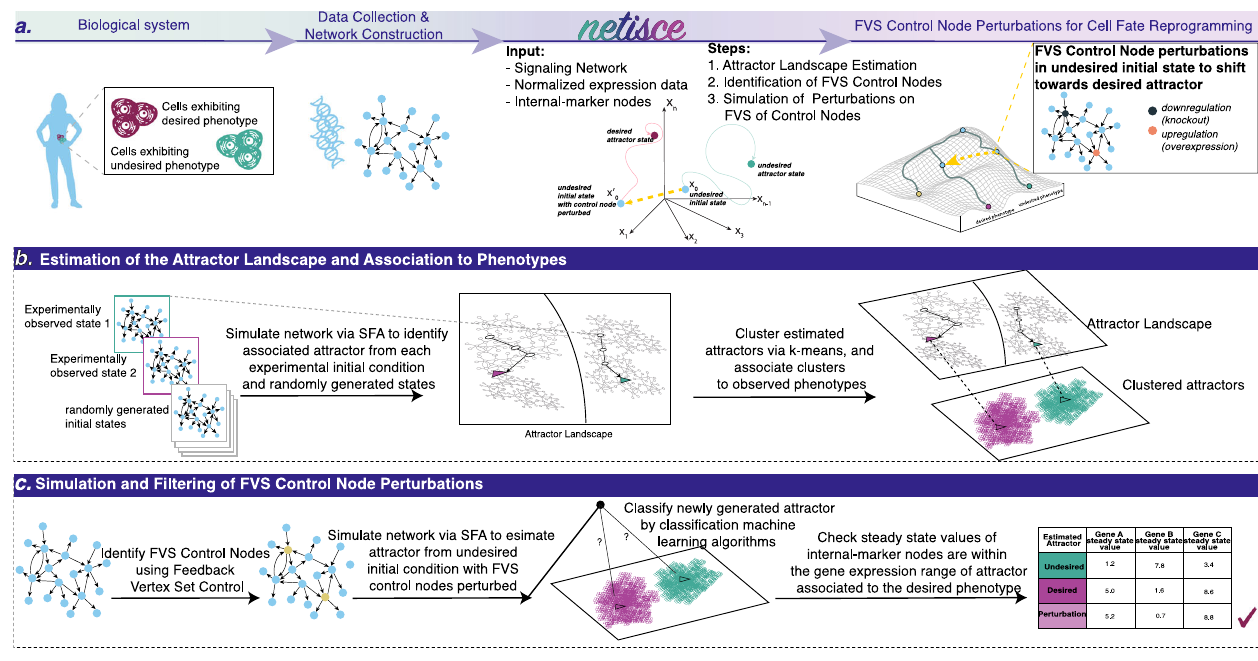
Fig. 2 NETISCE pipeline and method overview. a Researchers can collect data from cells exhibiting desired and undesired phenotypes and construct the signaling and regulatory networks governing cell reprogramming processes. The outputs of NETISCE are the combinations of network perturbations that shift the system from an undesired to a desired phenotype. b With the signal fl ow analysis (SFA) algorithm 47 , in the fi rst step, attractors are estimated by simulating the network with the initial states from normalized expression data and randomly generated initial states. The attractors are clustered via k -means, and the clusters are associated with desired (purple) and undesired (green) phenotypes. c In the second step, FVS control nodes are identi fi ed using an FVS- fi nding algorithm 84 . Perturbations on FVS control nodes are performed by setting the initial states of the system to the gene expression value of the undesired phenotype and overriding the states of FVS control nodes. In the third step, the sets of perturbations on FVS control nodes that achieve the desired reprogramming are identi fi ed using two fi ltering criteria. In the fi rst criterion, the attractors generated from the perturbations on FVS control nodes are fi ltered using machine learning classi fi cation algorithms to obtain a set of perturbations whose attractors shifted from the cluster associated with the undesired phenotype to the cluster associated with the desired phenotype. In the second criterion, for user-de fi ned internal-marker nodes, the expression values in the attractors produced by the perturbations that passed the fi rst fi ltering criterion (light purple) are evaluated to determine if their values have shifted to the expression range of the attractors associated with the desired